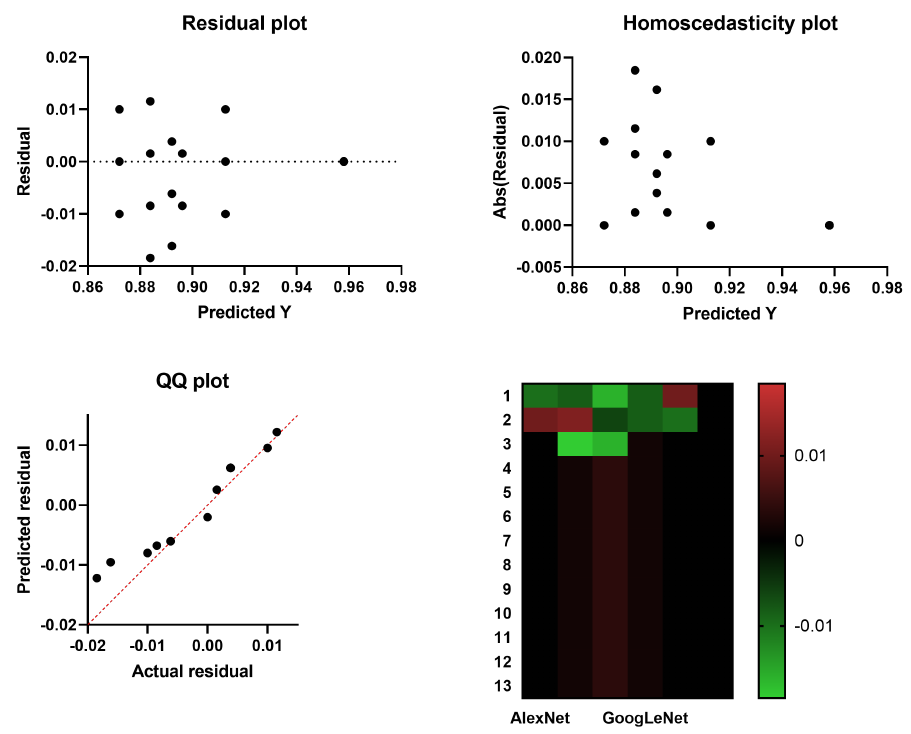
Figure 18. Residual, QQ plots, and heat map of the proposed BO-CNN model vs. pre-trained-CNN models for the OCT dataset.